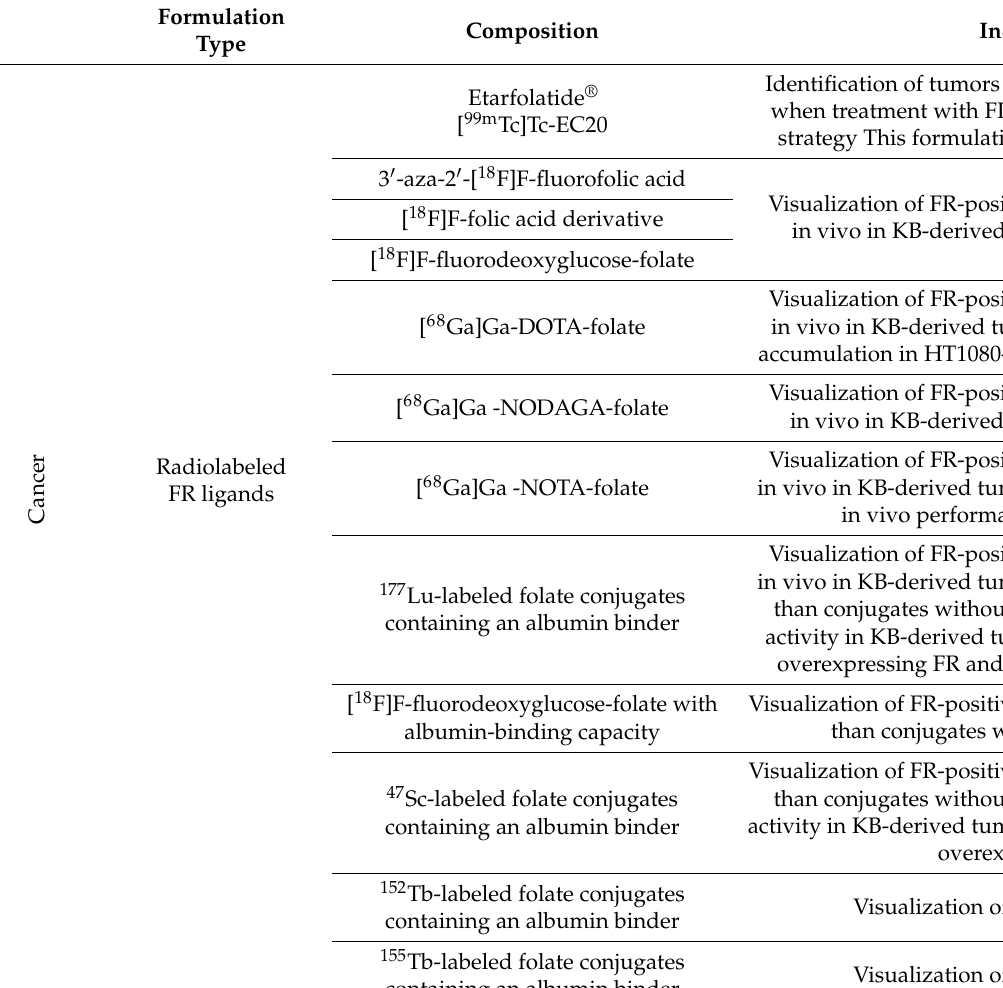
Stage Technique